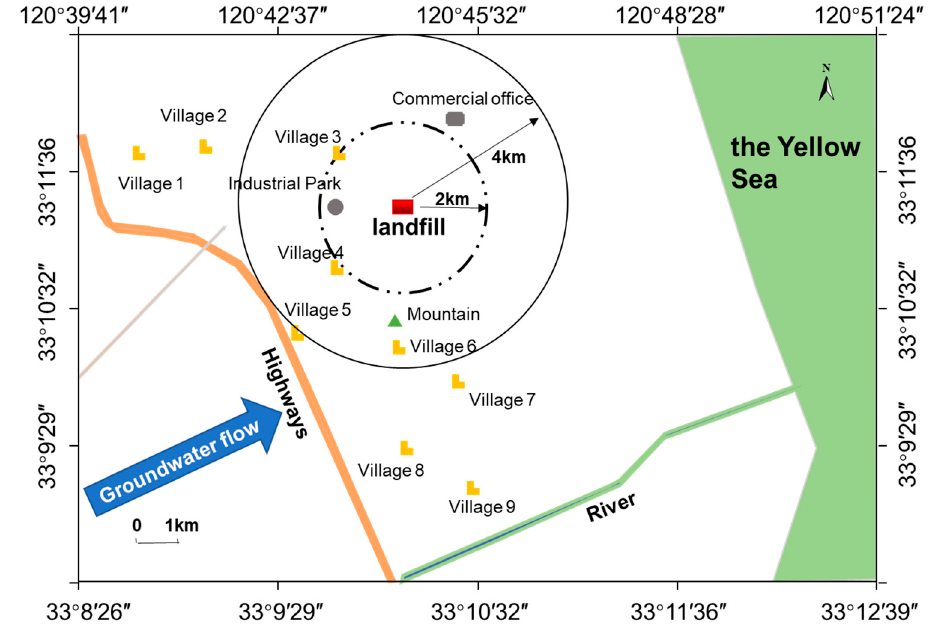
Figure 2. Overview of a hazardous waste landfill.